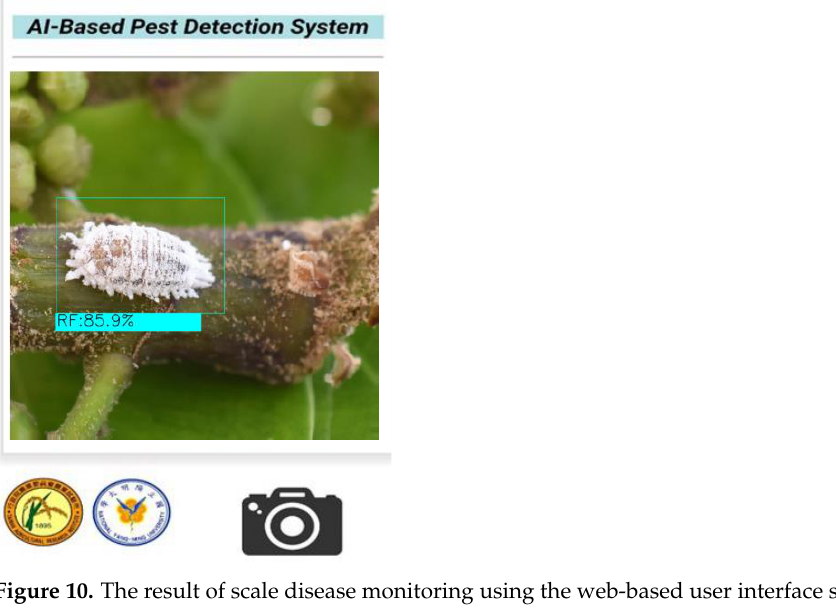
Figure 10. The result of scale disease monitoring using the web-based user interface system.